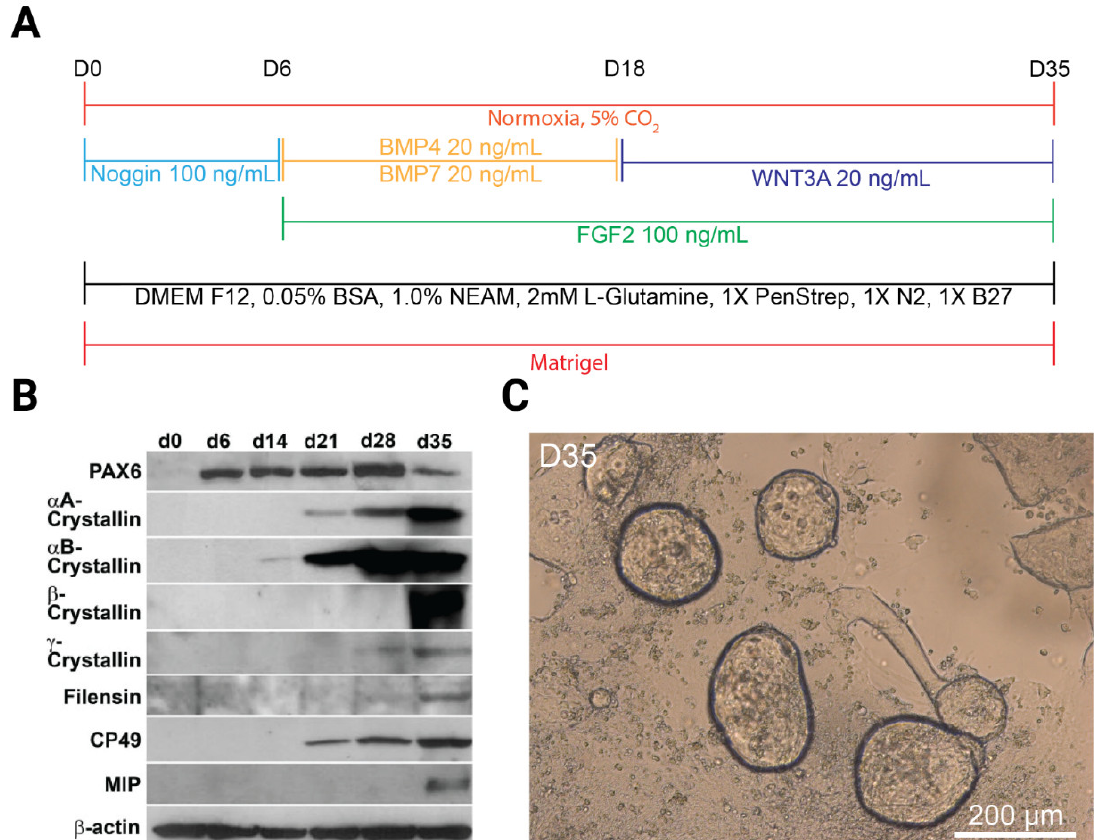
Figure 2. Summary of three-stage procedure to generate human lentoid bodies. ( A ) Lentoid bodies were differentiated over a 35-day period on Matrigel using specific concentrations of Noggin, BMP4, BMP7, FGF2, and WNT3A at the time points shown. Additional components and their concentrations of the basal medium are also shown [125]. ( B ) Western blot analysis shows expression of key lens markers PAX6, αA-, αB-, β-, and γ-crystallins, filensin (BFSP1), CP49 (BFSP2), and MIP (AQP0). Expression of β-actin was used as a loading control [125]. ( C ) Brightfield image of lentoid bodies produced at day 35 of differentiation.